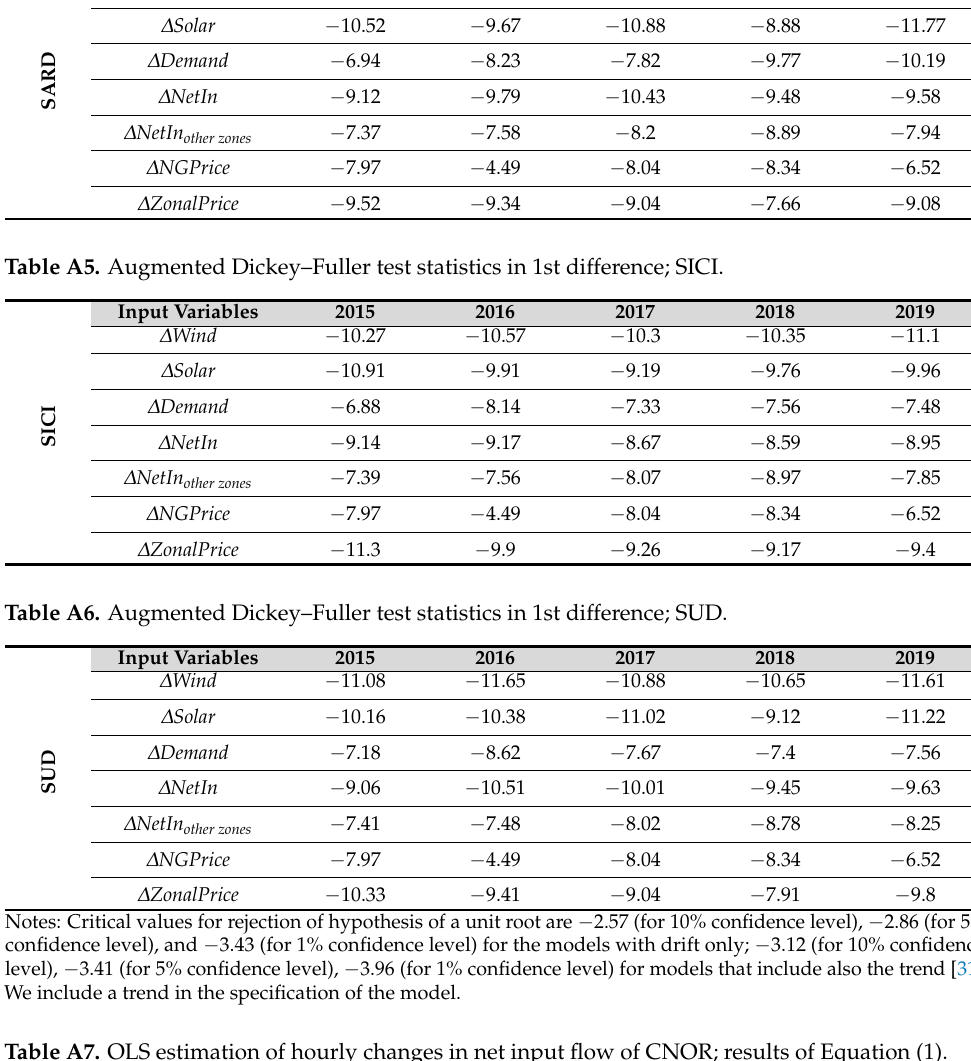
Table A7. OLS estimation of hourly changes in net input flow of CNOR; results of Equation